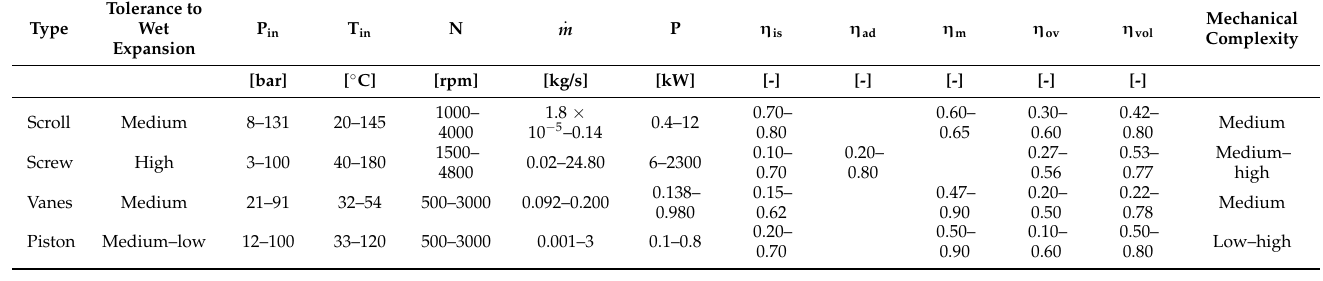
Table 5. Summary of the performances of two-phase volumetric expanders.